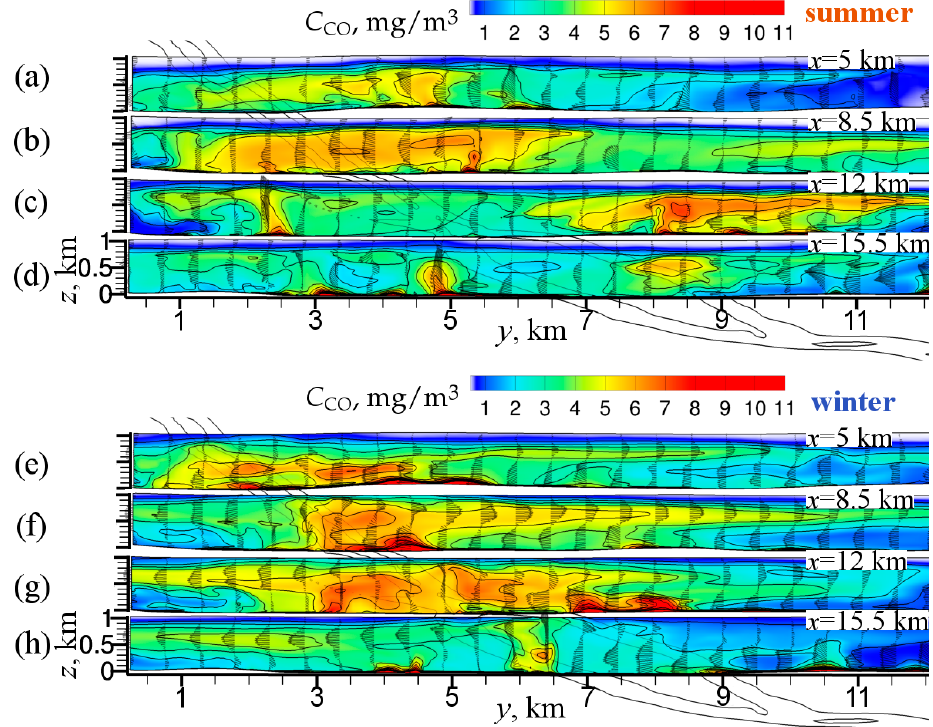
Figure 4. Instantaneous CO concentration distribution and velocity vectors in several vertical cross-sections (along the y -axis) across the river at 1800 LT. ( a – d ) Summer; ( e – h ) Winter.